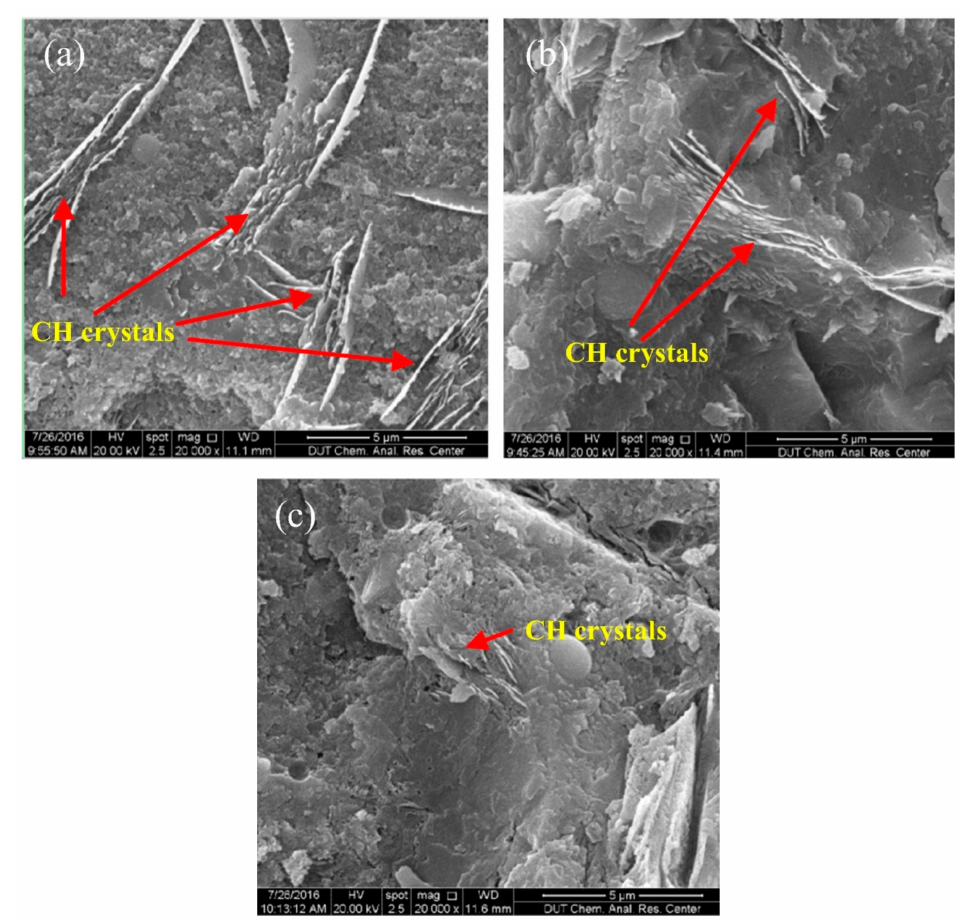
Figure 2. SEM micrographs of CH crystals in concrete with nano-SiO 2 -coated TiO 2 at curing age of 28 days (20,000 × ): ( a ) sample T0; ( b ) sample T3; ( c ) sample T5. Reprinted with permission from [80].